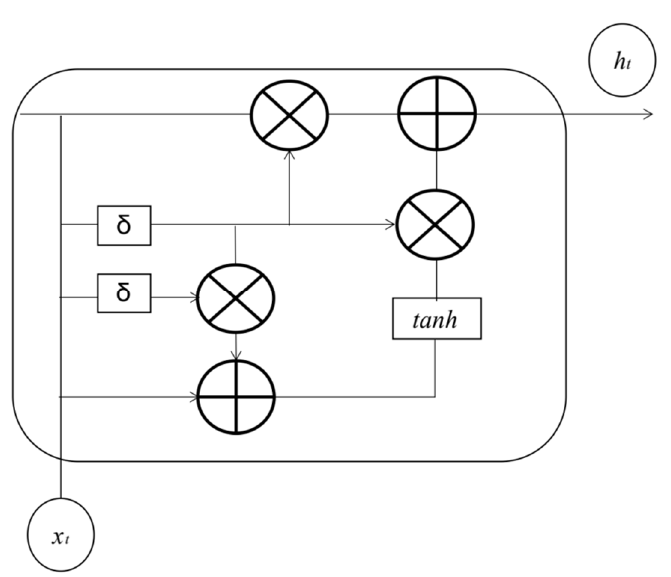
Figure 4. GRU structure. Figure 4. GRU